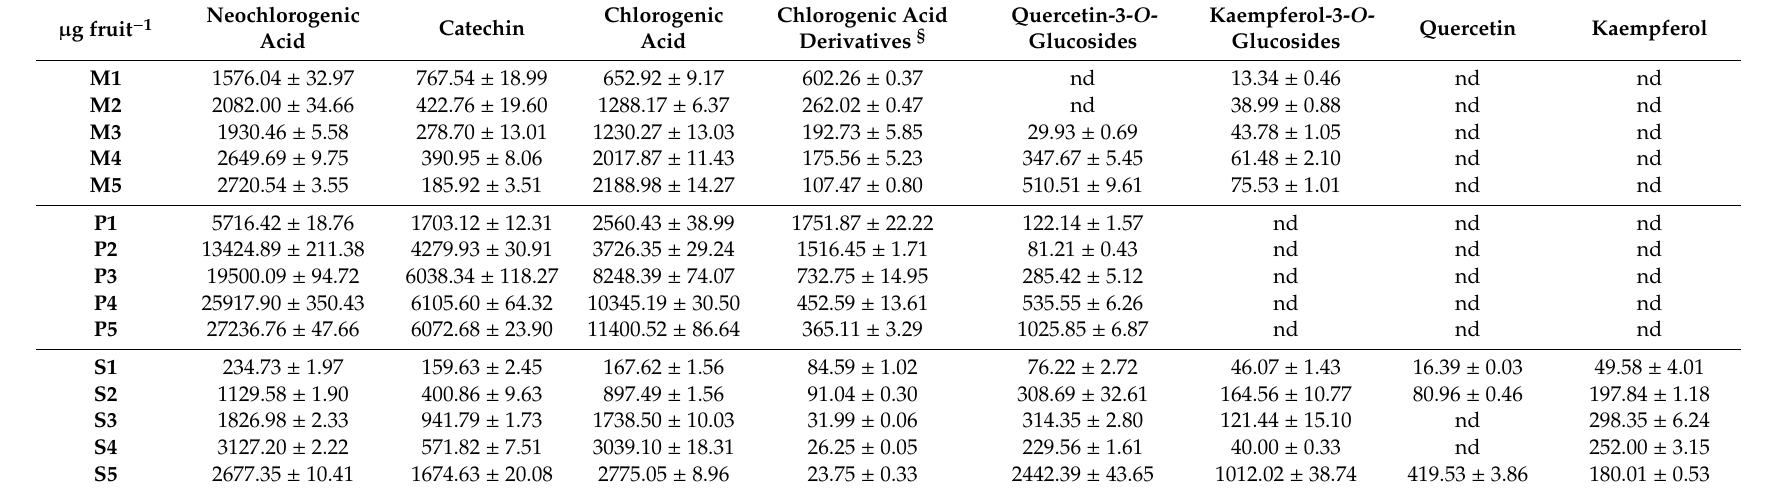
Table 4. Content of phenolic compounds ( µ g fruit − 1 ; mean value ± standard error, n = 3) in the fruit flesh of the three species of plum* at di ff erent development